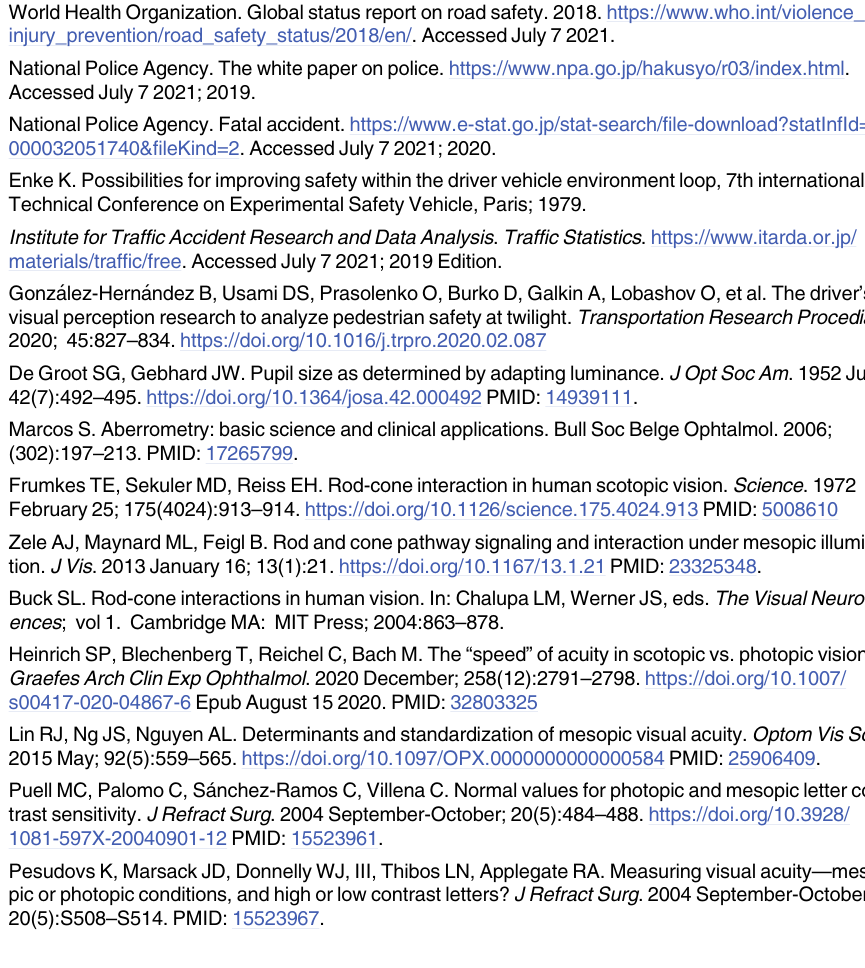
S1 Table. Subjective refraction and visual acuity measurement data for each subject (n =